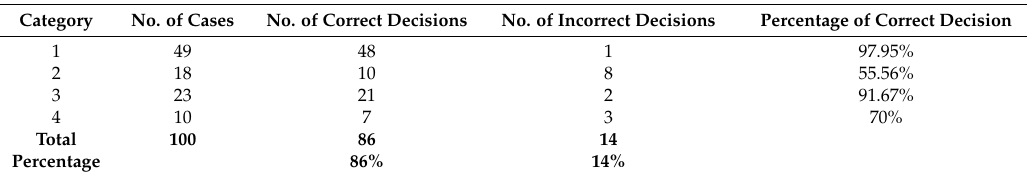
Table 7. Details of decisions made by RNN for each